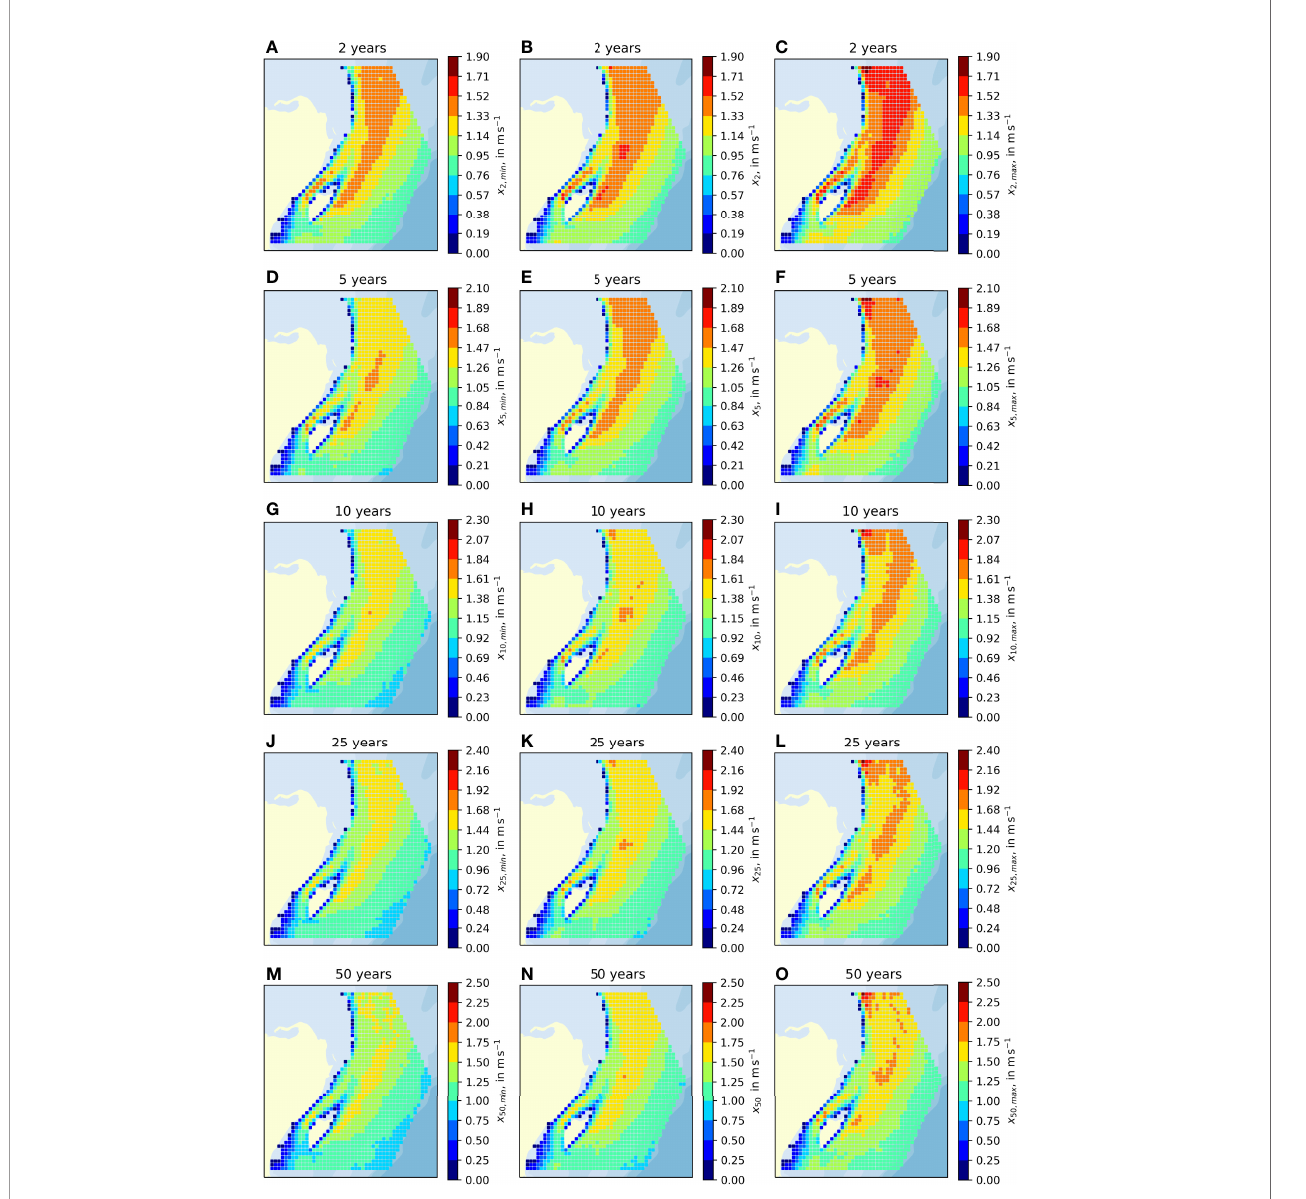
FIGURE 7 | Return levels for 50m depth for different return periods. All the fi gures in one row correspond to the same return period; (A – C) 2 years, (D – F) 5 years, (G – I) 10 years, (J – L) 25 years, and (M – O) 50 years. The left column shows the lower bound of the CI 95% , the right column the upper bound of the CI 95% , and the central column the predicted return